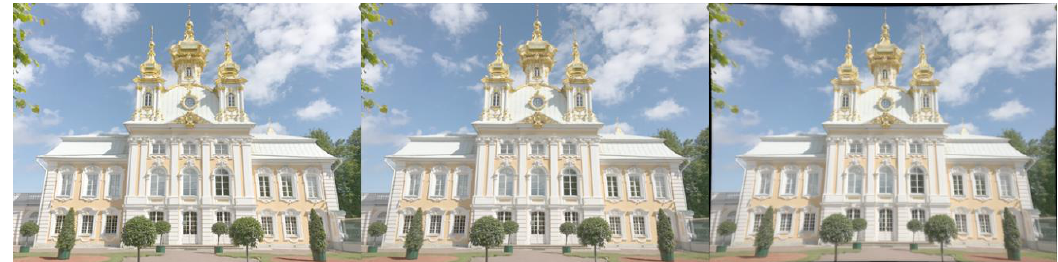
Figure 12. ( a ) Original (photographer: C. P. Chen, location: Peterhof Grand Palace, St. Petersburg, Russia), ( b ) real, and ( c ) virtual images. Compared to the original one, the real image is virtually lossless, while the virtual image has a mild pincushion distortion and slightly decreased